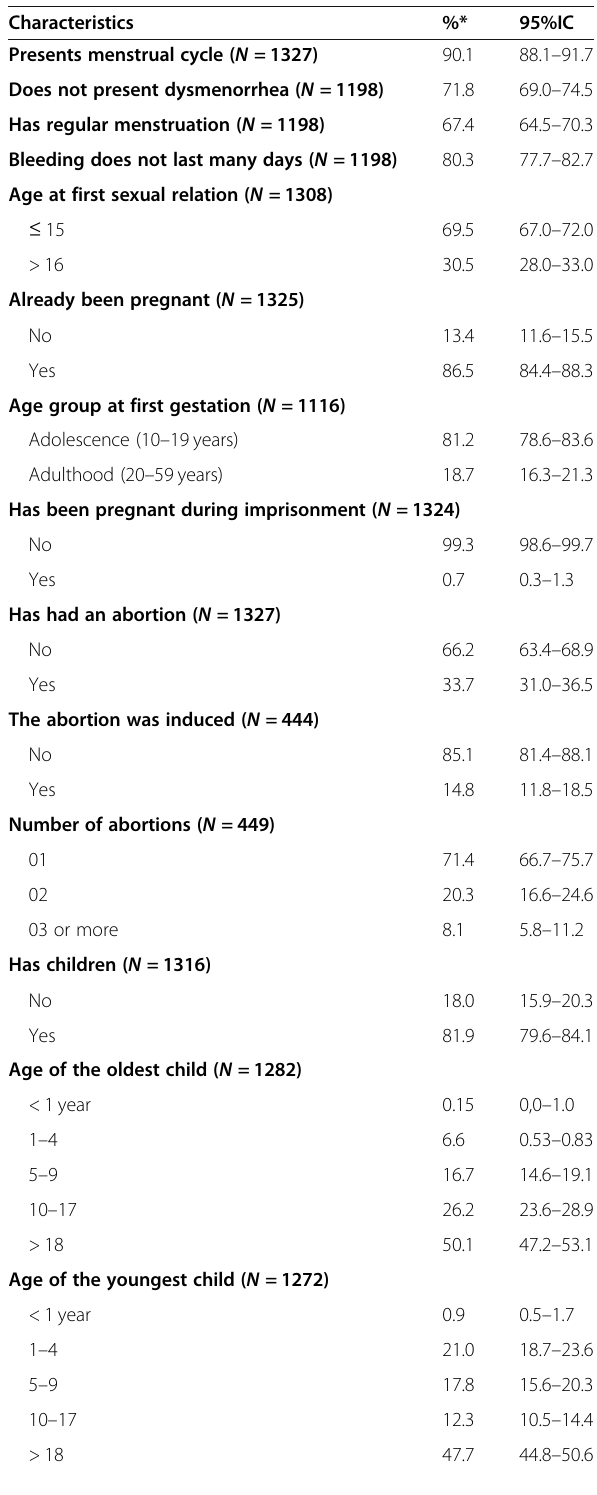
Table 2 Reproductive health characteristics of incarcerated